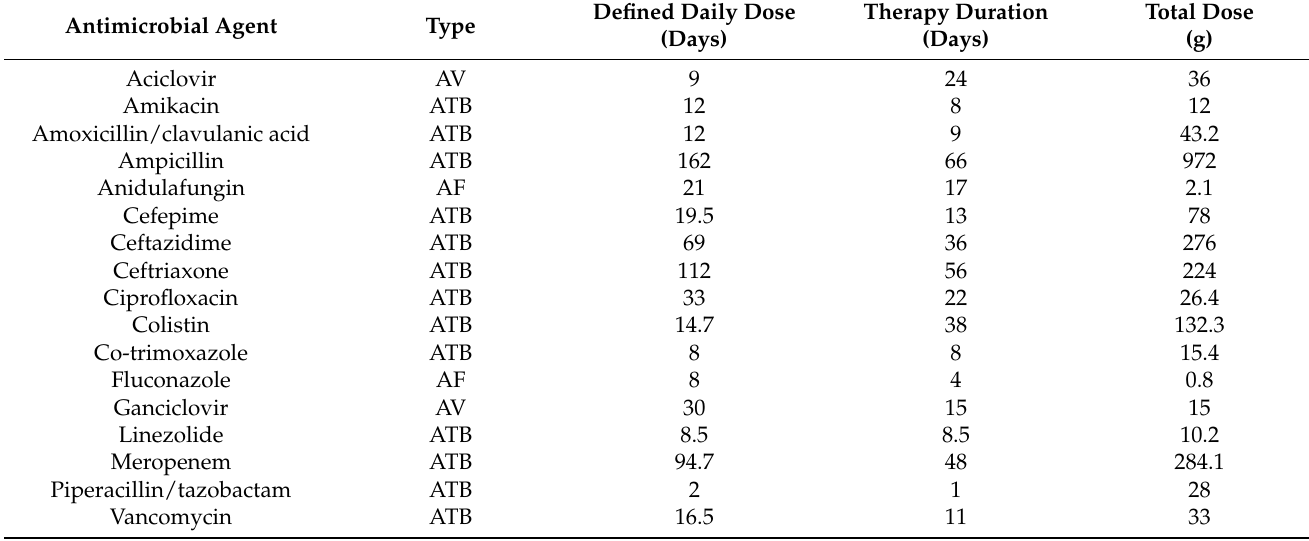
Table 2. Antimicrobial doses during 207 days of VV-ECMO support until lung transplantation. Antimicrobial